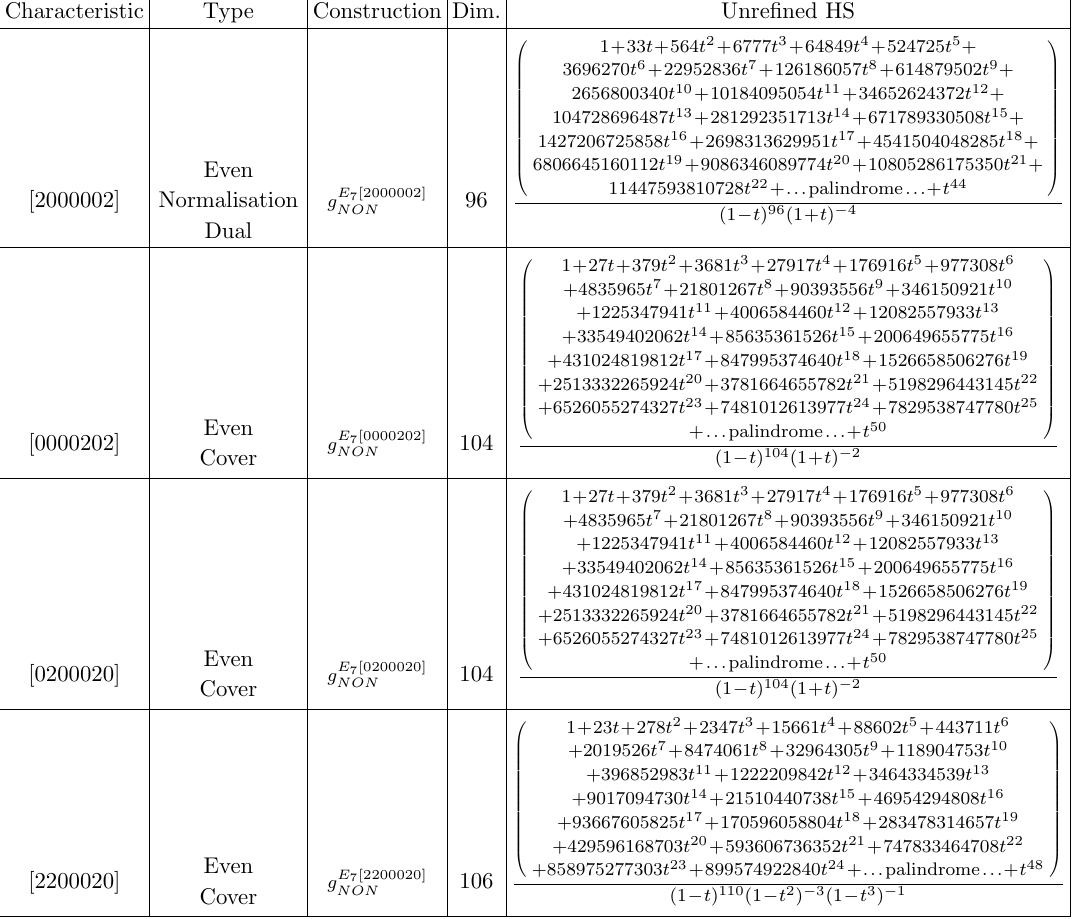
Table 26 . E 7 extra moduli spaces and Hilbert series (A). These moduli spaces are associated with SU(2) homomorphisms but do not represent additional nilpotent orbits (see